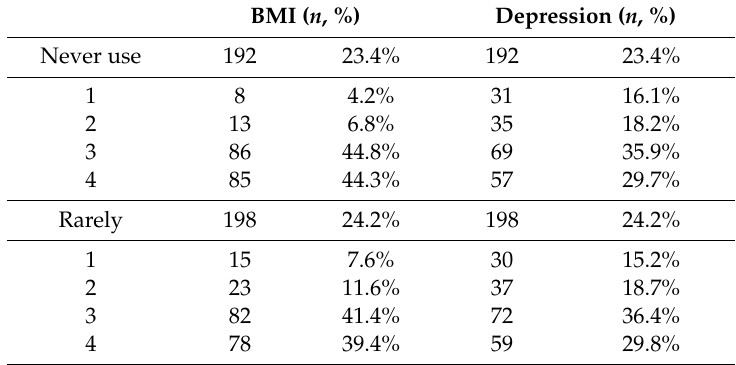
Table 2. Distribution of BMI and depression in di ff erent frequency of using fitness